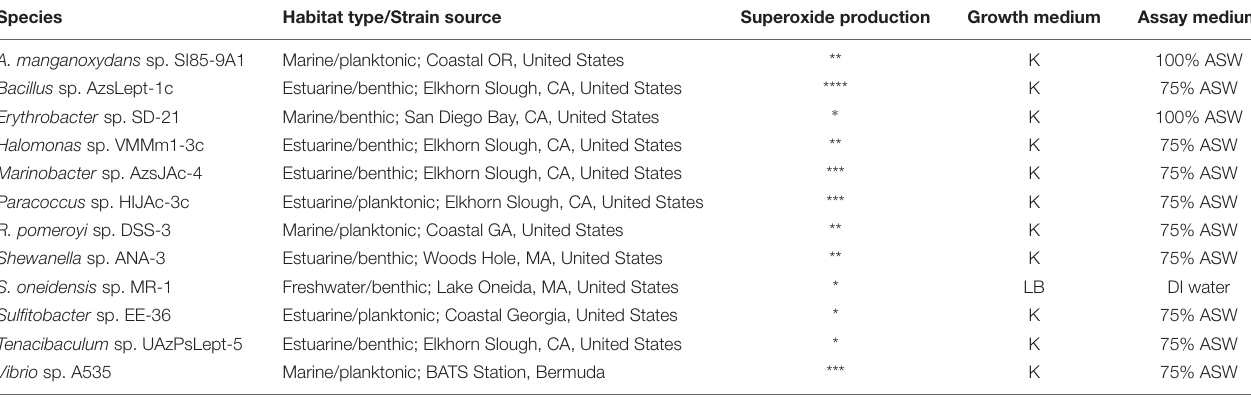
TABLE 1 | Bacterial strains selected for present